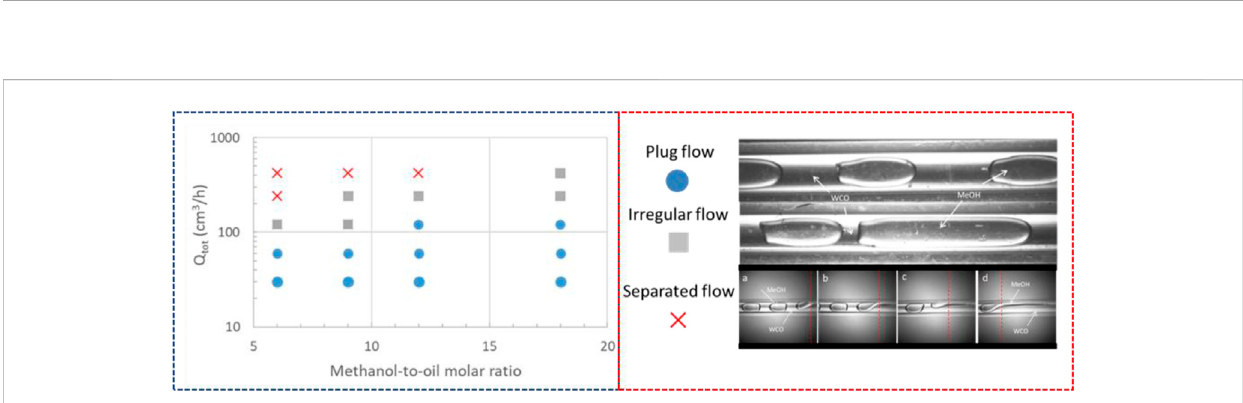
FIGURE 4 Flow pattern map of WCO-methanol two-phase fl ow at the initial part of the channel using a cross- fl ow mixer at 60 ° C (Catalyst concentration at 1.4% w/w). In “ separated fl ow ” image, (A – D) subscripts show the evolution from plug to separated fl